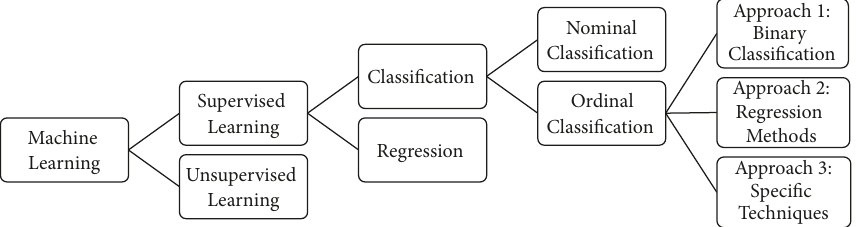
Figure 1: The classification methods of machine